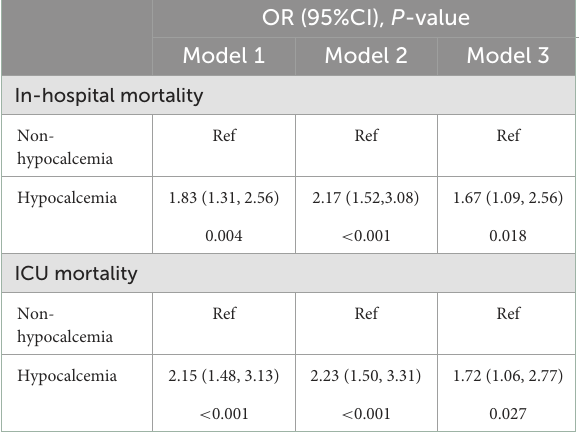
TABLE 3 Association of hypocalcemia with mortality in critically ill patients with ICH. OR (95%CI), P -value Model 1